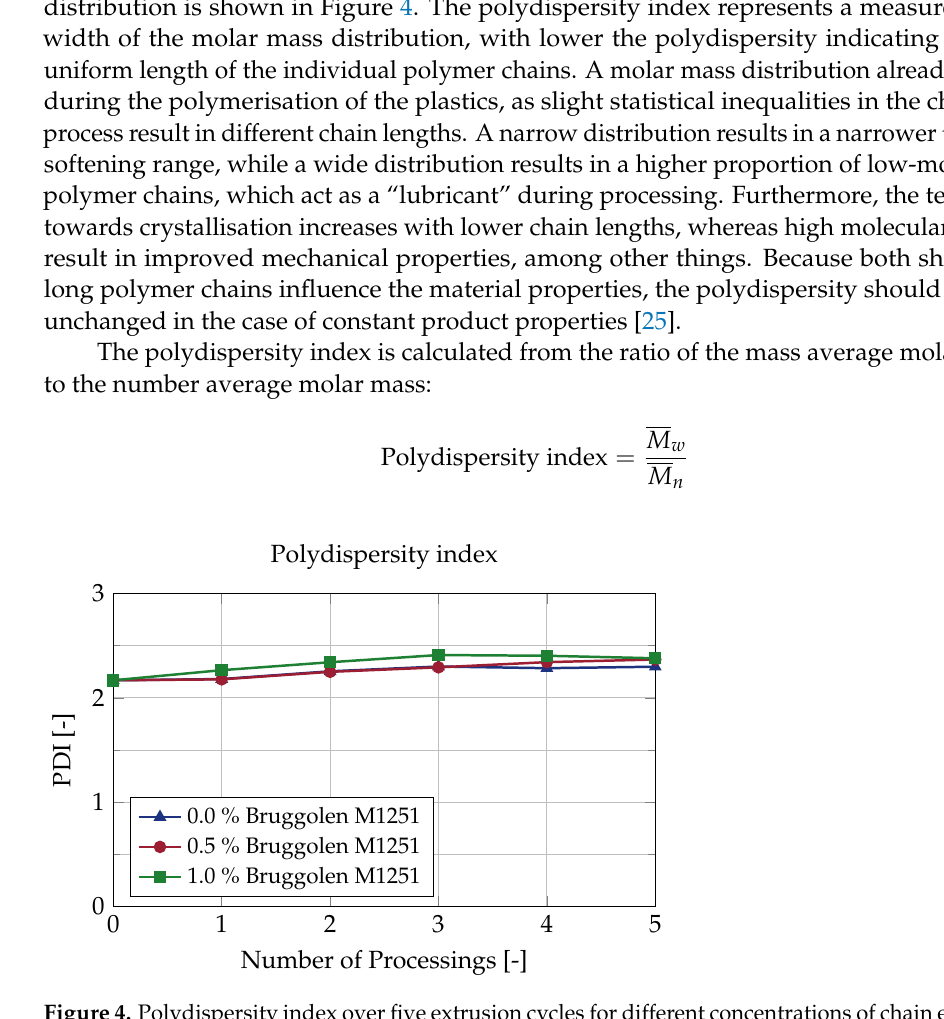
Figure 4. Polydispersity index over five extrusion cycles for different concentrations of chain